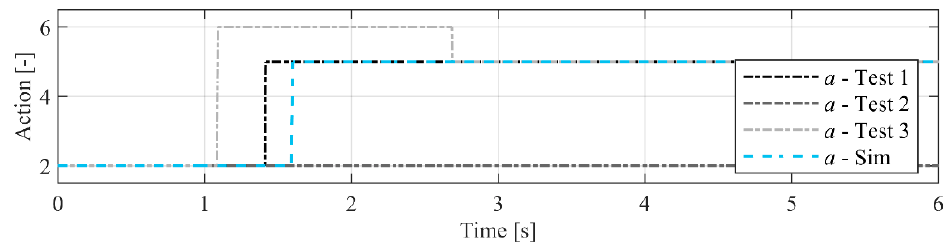
Figure 15. Issues with repeatability for 120 kg load and 𝑝 (cid:3013)(cid:3020),(cid:2869) = 60 bar.